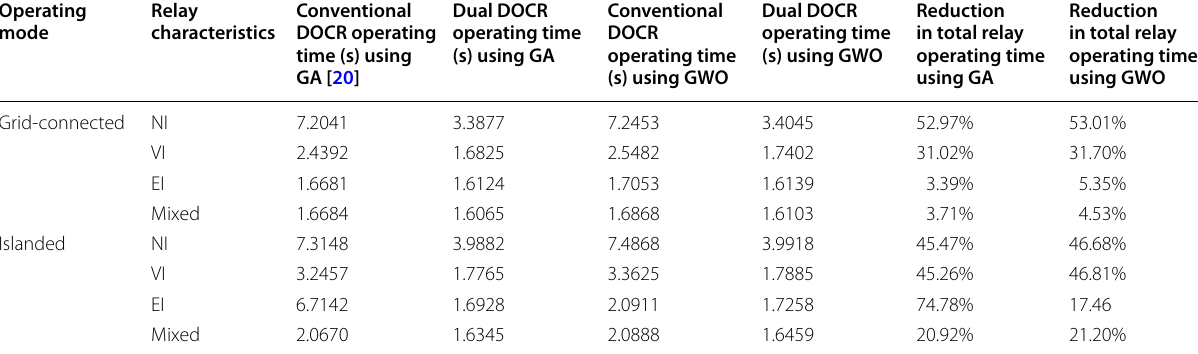
Table 6 Comparative analysis of conventional DOCR [20] and dual setting DOCR for 7-bus microgrid system Operating mode